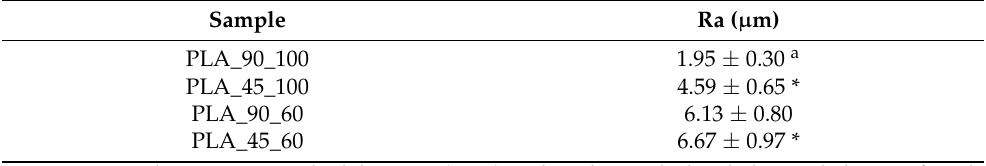
Table 2. Data relevant to surface roughness analysis.